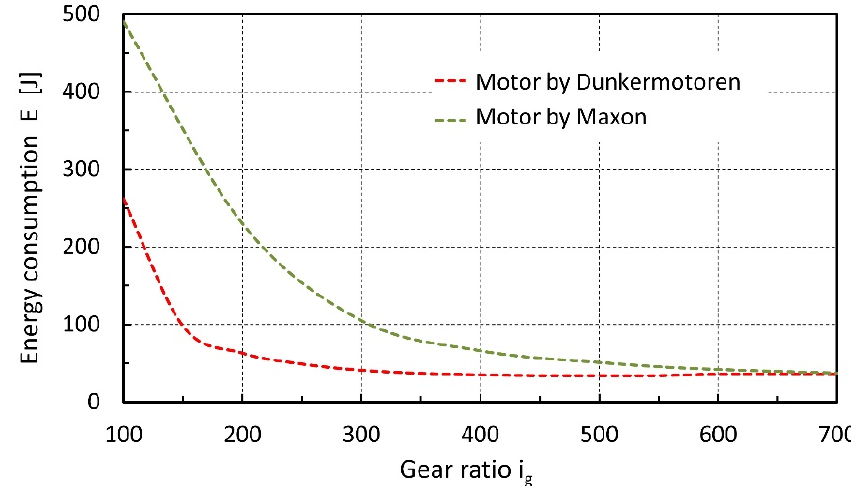
Figure 10. Effect of the gear ratio on energy demand during one cycle of the gait.